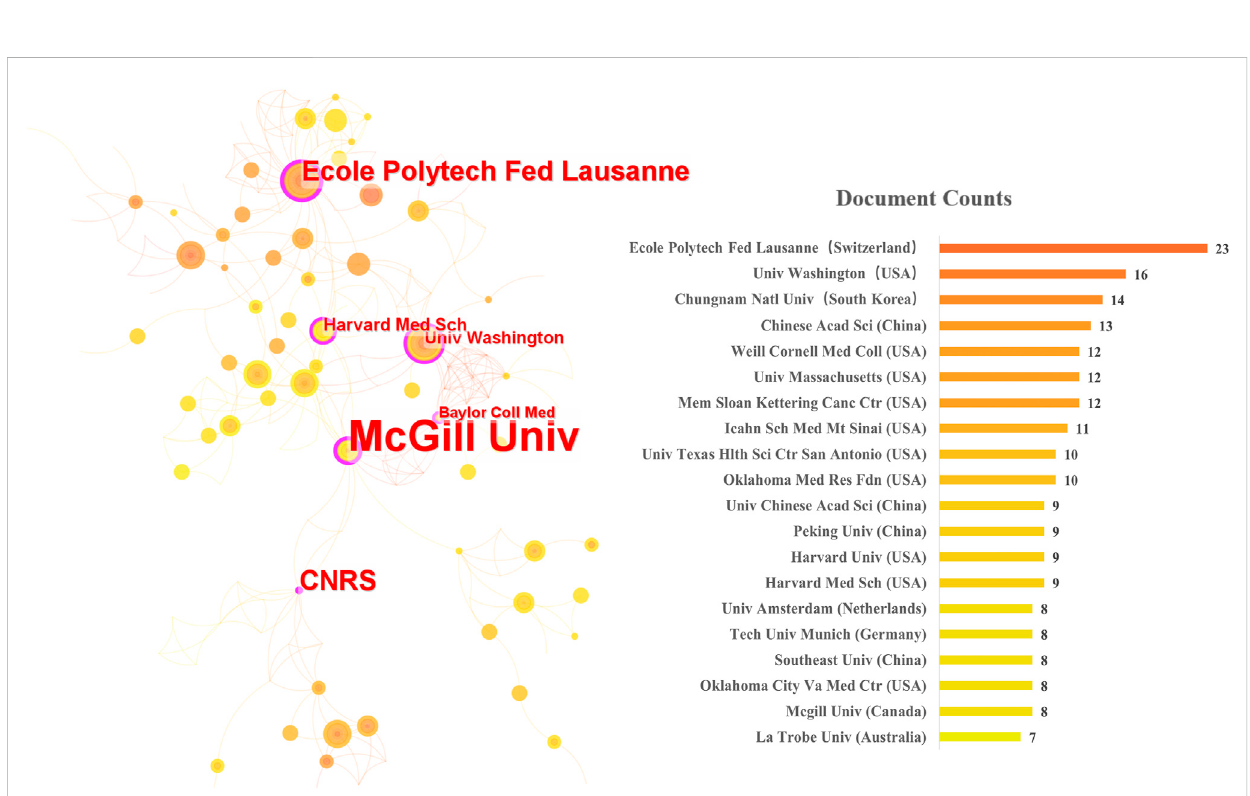
Institution collaboration networkand top 10 af fi liations in UPR mt .